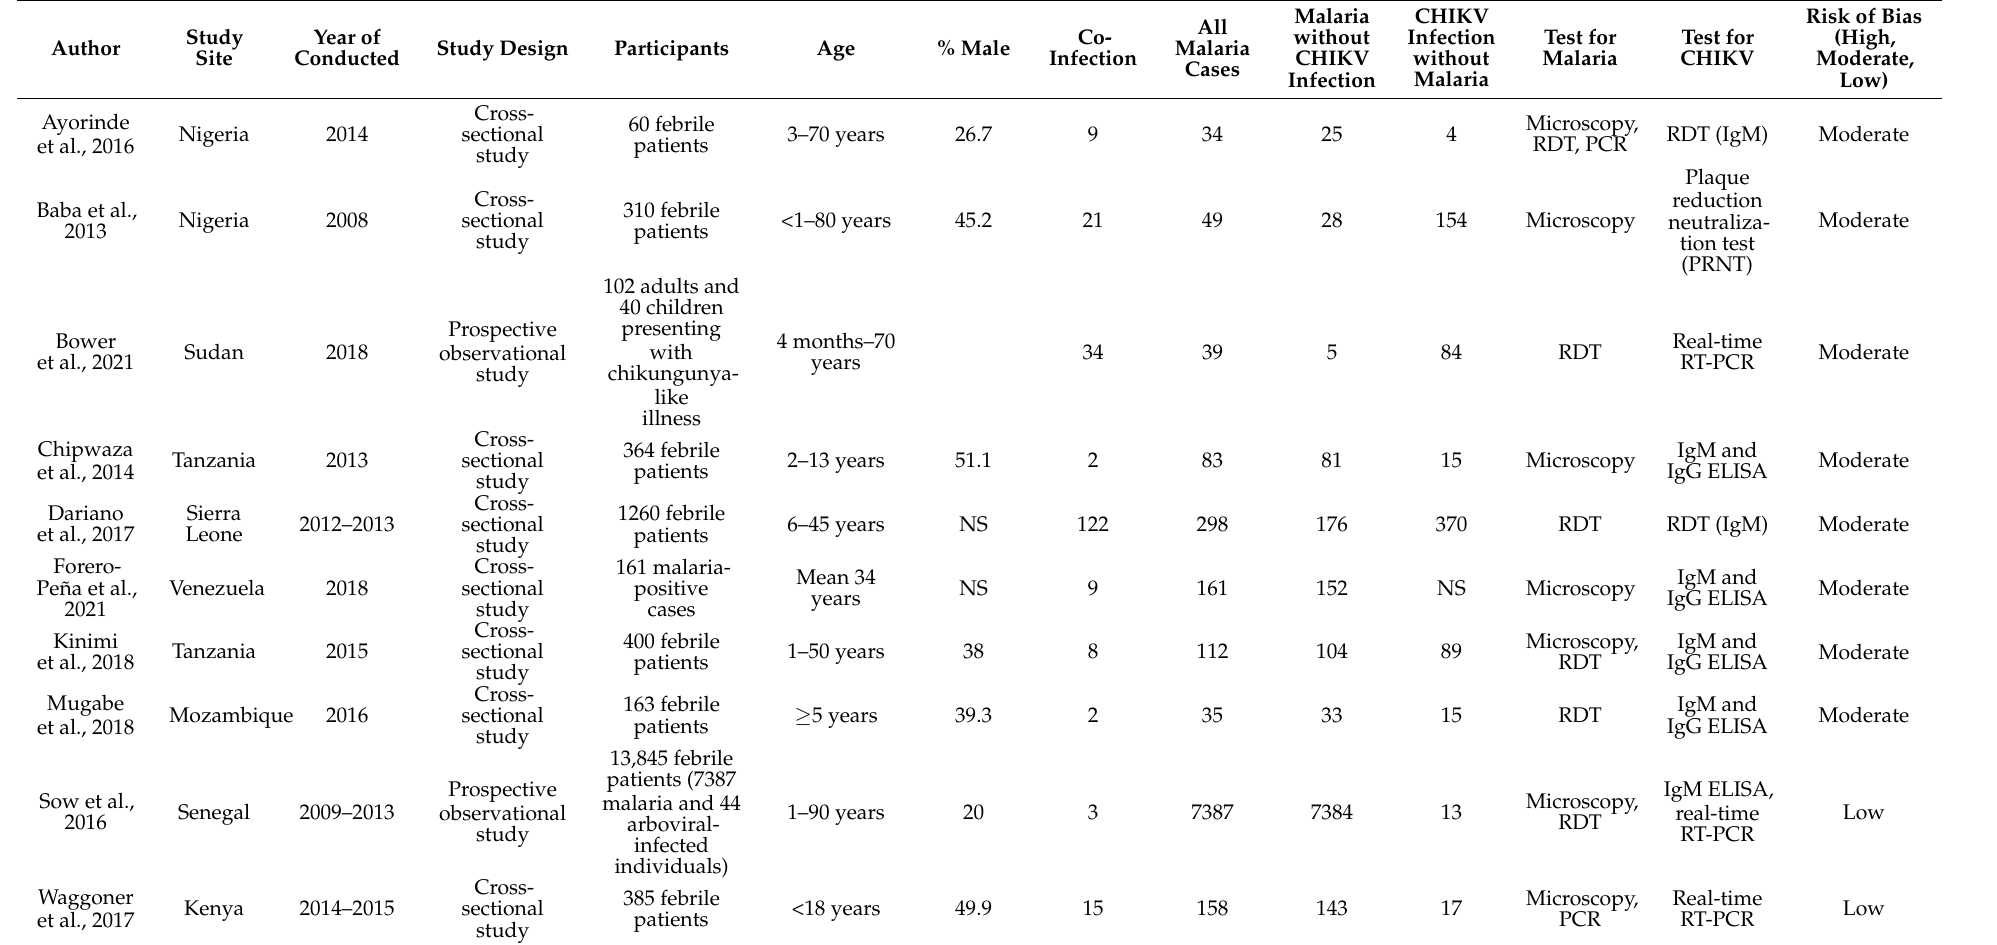
Table 1. Characteristics of the included